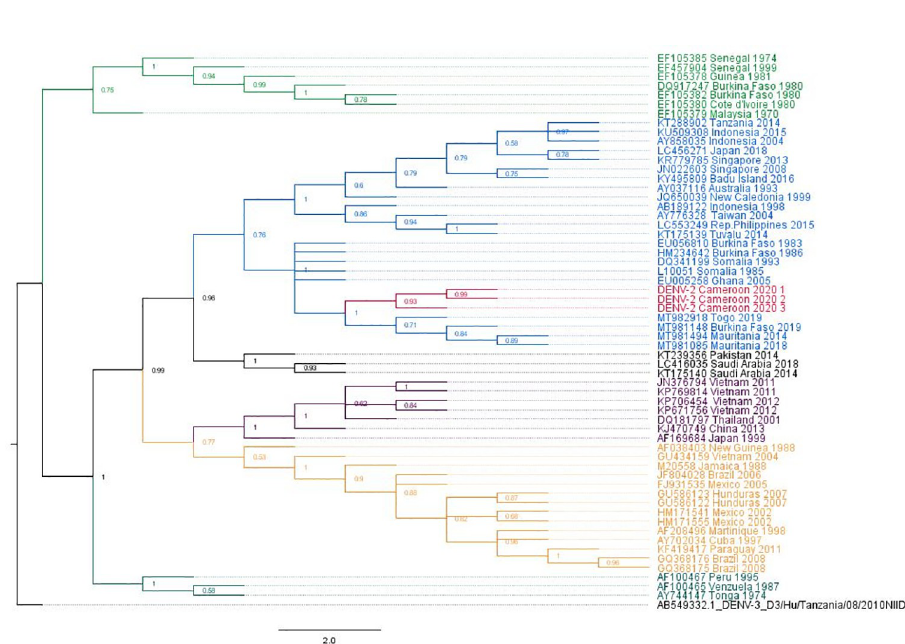
Fig 3. Dengue virus 2 phylogenetic tree built with a 1387 bp fragment of the envelope gene. The maximum likelihood tree was built using the TN-93 +G+I model. Each DENV genotype is represented by a single colour. The three sequences from this study are highlighted in red. The tree node value represented the bootstrap expressed in decimal. Dengue virus 3 from Tanzania was used as outgroup. DENV2 strains from Cameroon belong to genotype II along other African strains. It forms a sister clade with those responsible of the recent outbreaks in West